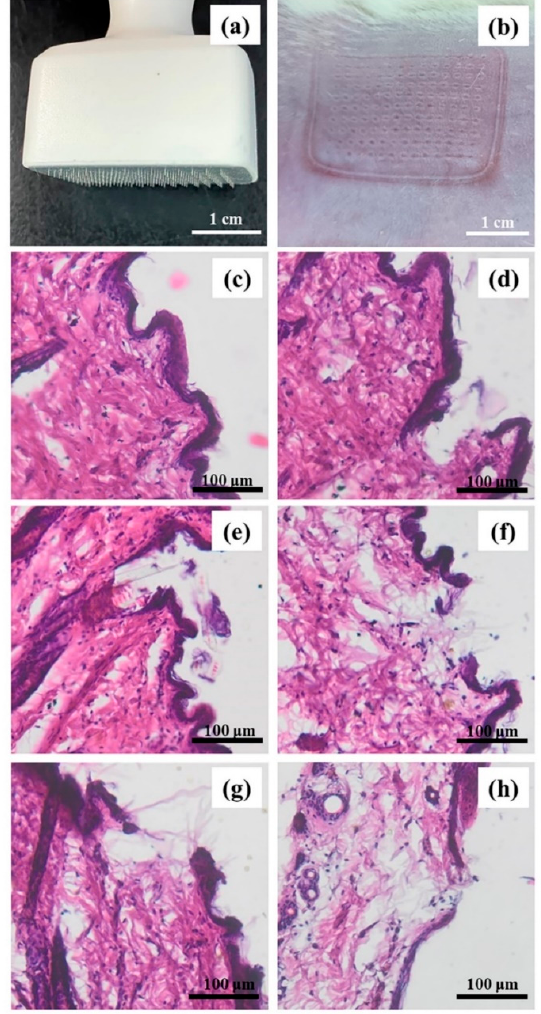
Figure 8. ( a ) The microneedles used in the study; ( b ) the skin treated by microneedles; ( c – h ) light microscope observation of H&E strained longitudinal sections to identify the microchannels in the skin tissues after being treated by microneedle at different times: ( c ) control group; ( d ) 0 min; ( e ) 5 min; ( f ) 10 min; ( g ) 30 min; ( h ) 1 h.